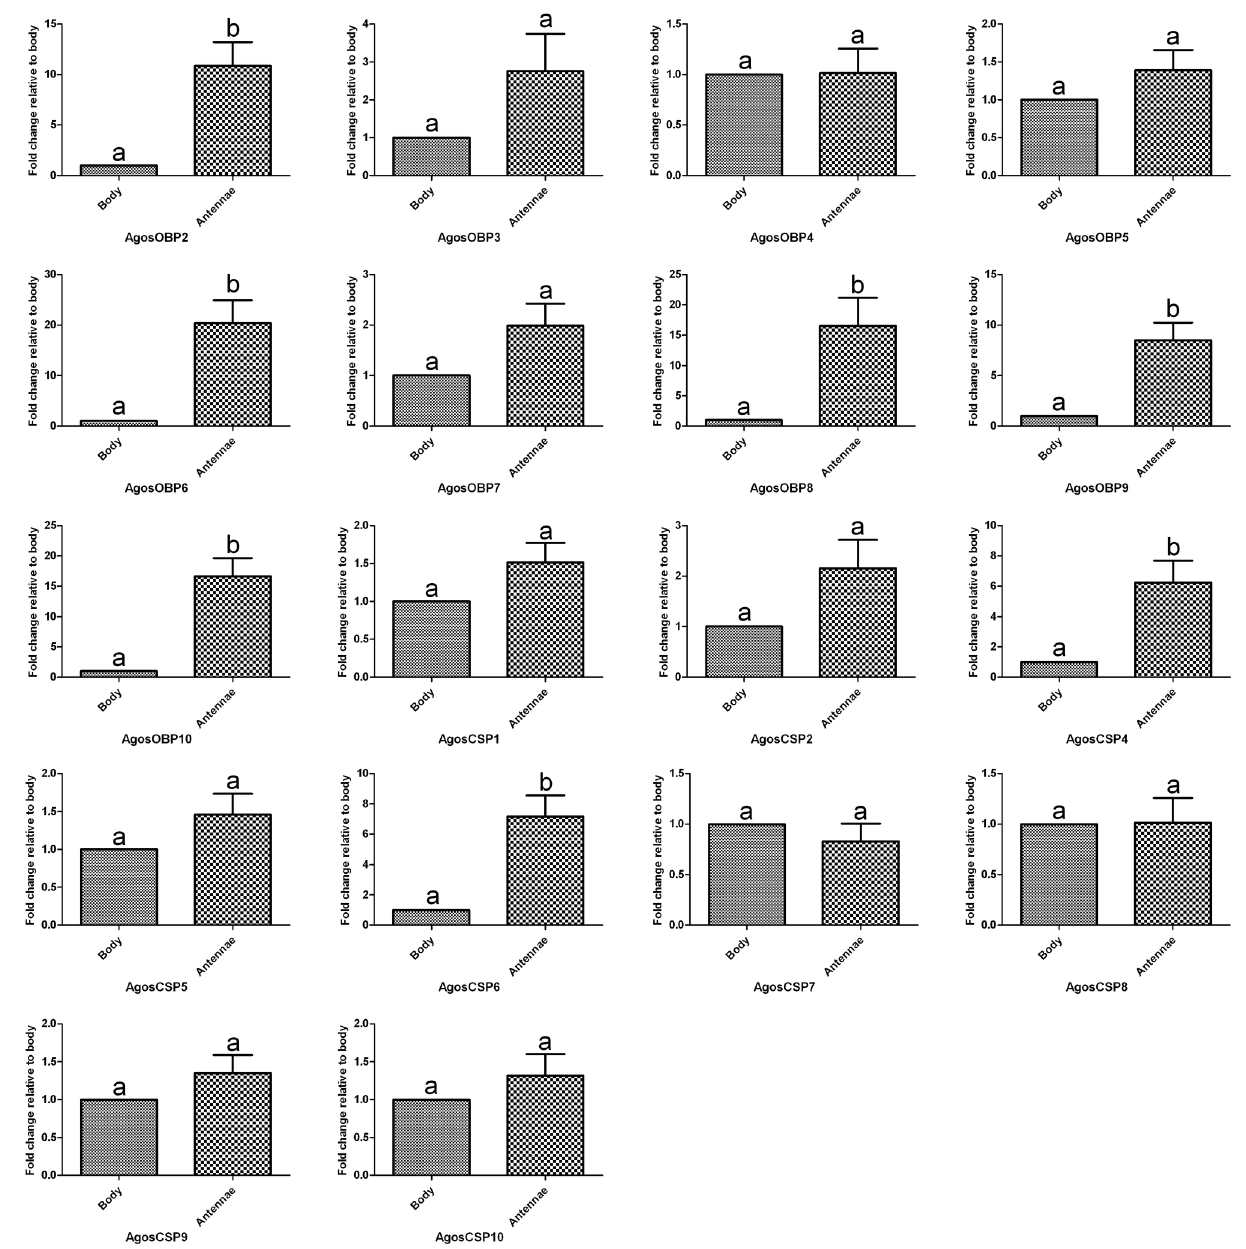
Figure 7. Tissue-specific expression profiles of A . gossypii OBPs and CSPs as measured by qRT-PCR . The fold changes are relative to the transcript levels in the body. Standard errors represented by the error bars, and the letter above each bar indicates the statistical differences; the bars with different letters (a, b, c) indicate significant differences ( p <0.05) and with same letters indicate no differences between mean expression